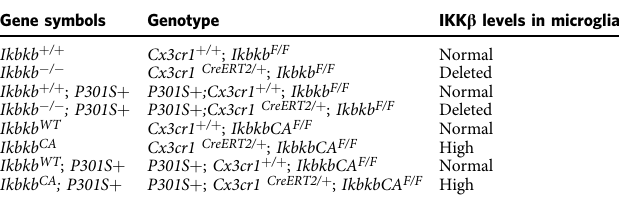
Fig. 8 Hypothetical model of microglia NF- κ B drives tau seeding/spreading and toxicity. a In an acute model of young PS19 mouse, microglia process the inoculated exogenous tau and release seedable tau to drive tau spreading in a month. Microglial NF- κ B activation accelerates the spread of tau inclusions seeded by the inoculation of exogenous tau seeds, likely due to increased tau secretion and impaired autophagy, which is rescued by NF- κ B inhibition. b In the non-seeded PS19 model, tau aggregation in aged neurons is determined by tau proteostasis of neurons expressing human mutant tau transgene. Microglial NF- κ B activation drives while deletion rescues tau toxicities. NF- κ B activity drives down intraneuronal inclusions via unknown mechanisms, likely via stimulating tau release and/or proteolytic cleavage in these